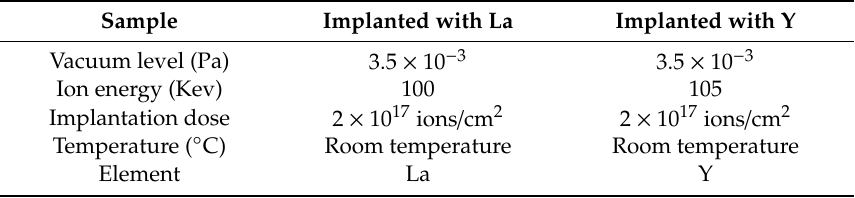
Table 1. Parameters of ion implantation before